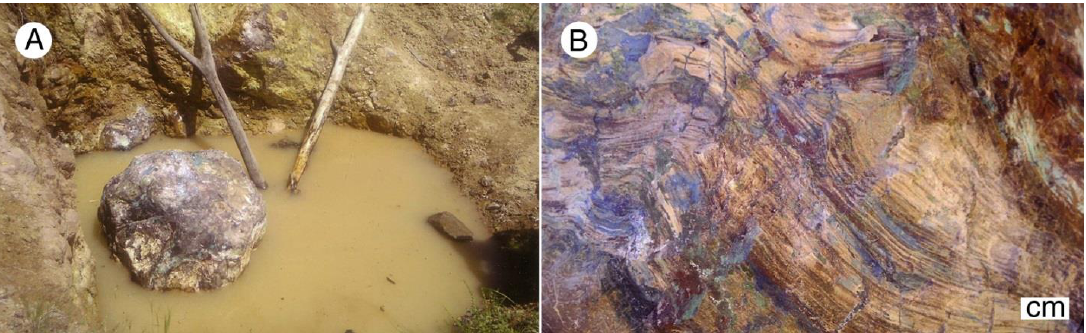
Figure 19. Copper-mineralized silicified log near Zile, Turkey, photographed at the discovery site in 2013. ( A ) Most specimens sold for export were obtained from this log ( B ) close-up view of the surface. Photos courtesy of Ziledin Haberler, used with permission.